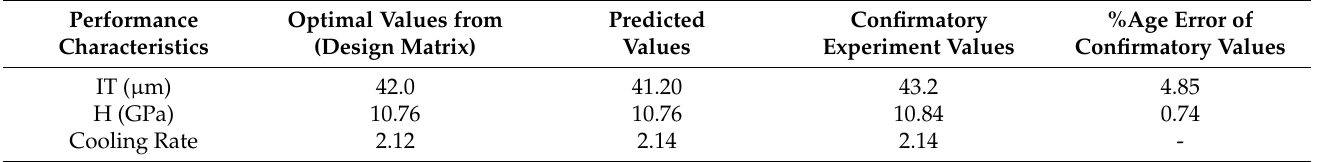
Table 9. Confirmation